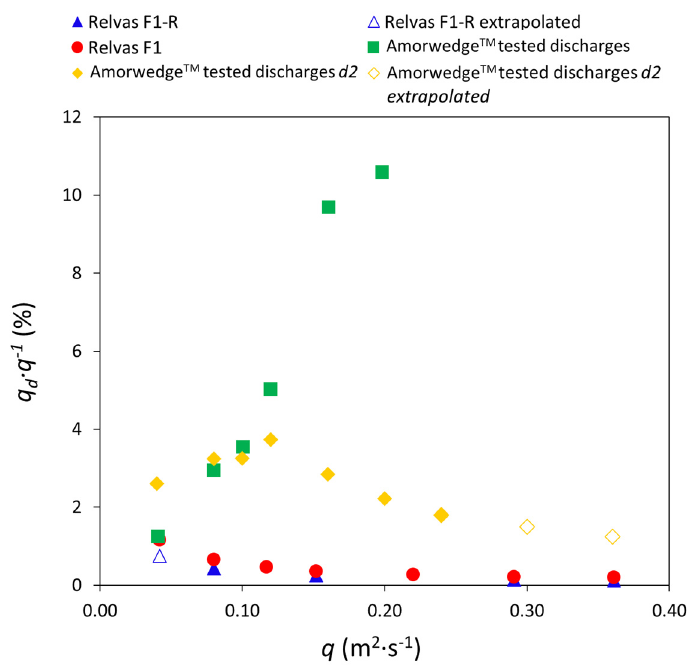
Figure 24. The unit drainage flow ( q d ) expressed as a percentage of the inlet flow rate ( q ).